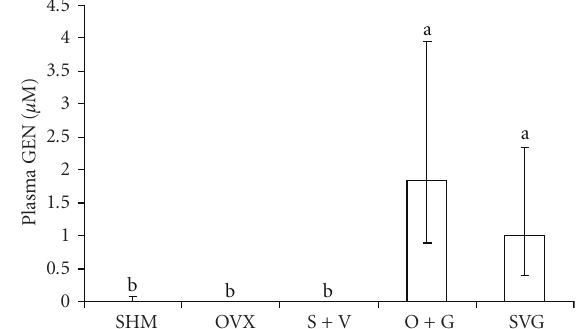
Figure 4: A comparison of plasma GEN concentrations as a result of dietary treatments in mice. Data represent the group median and error bars indicate the interquartile range for samples collected after 18-wk GEN or no-GEN in the base diet. The Kruskal-Wallis test for nonparametric data revealed a significant di ff erence between groups ( P < . 0001), and values with a di ff erent letter are statistically di ff erent based on Dunn’s post hoc multiple comparison